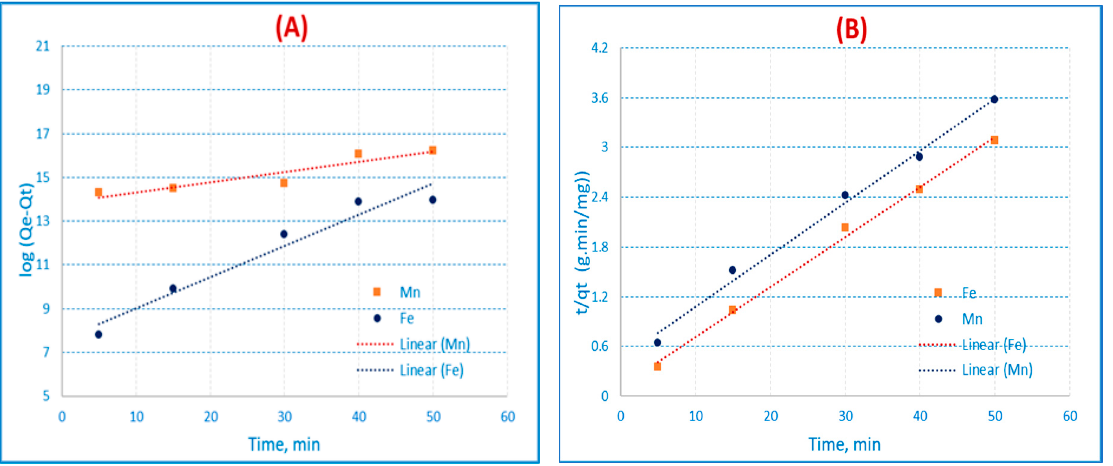
Figure 9. Kinetic ( A ) pseudo-first order and ( B ) pseudo-second-order on AC(C-3) for Fe(III) and Mn(II) respectively (conc. = 50 mg/L, t = 60 min, shaker = 100 rpm, and pH = 3 for Fe(III), and pH = 6 for Mn(II) at 25 °C). Table 11. Kinetic parameters for adsorption of Fe(III) and Mn(II) using AC(C-3), respectively.